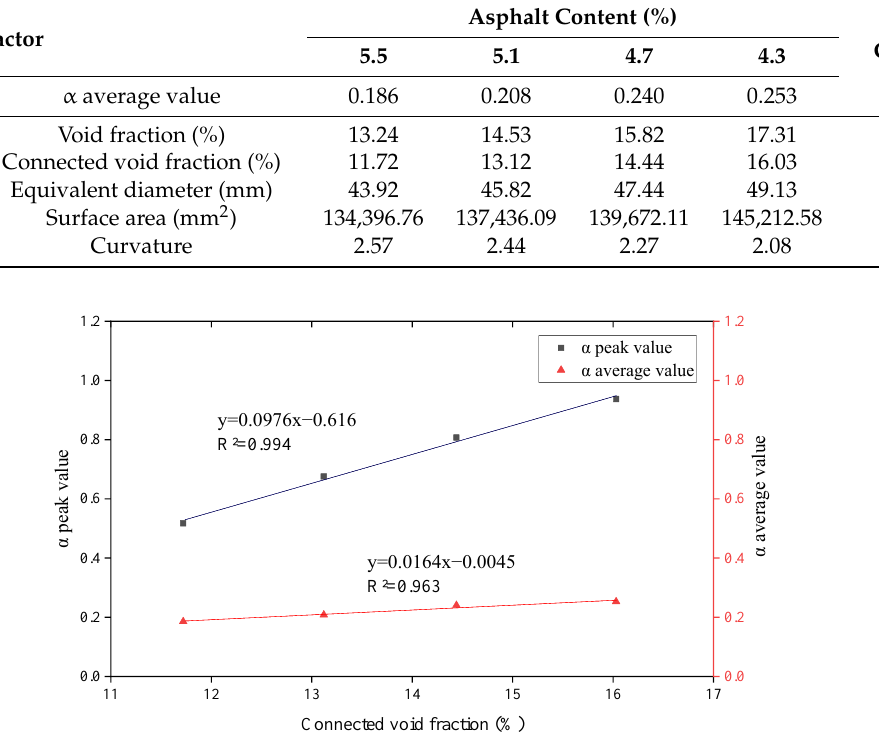
Figure 12. Fitting curve of the peak and average values of the sound absorption coefficient with the connected void fraction.